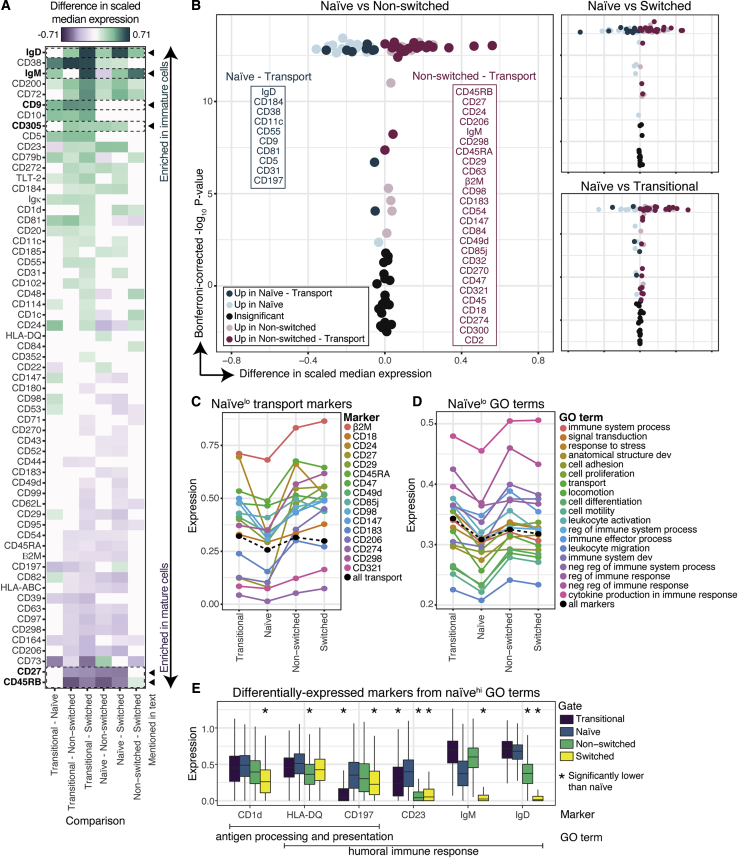
Differential expression analysis reveals the anergic profile of naive B cells(A) Difference in median expression for each pairwise comparison of subsets. All non-white tiles are significant (p < 0.005).(B) Volcano plots of the comparisons, colored by association with the GO term “transport.” Significantly different molecules listed in boxes are ordered by decreasing magnitude of difference of expression.(C) Median expression of transport molecules (colors). Mean of median expression of all transport molecules (black).(D) Mean of median expression of molecules associated with GO terms (color). Mean of median expression of all molecules (black).(E) Expression of six molecules more highly expressed in naive cells (p < 0.005).